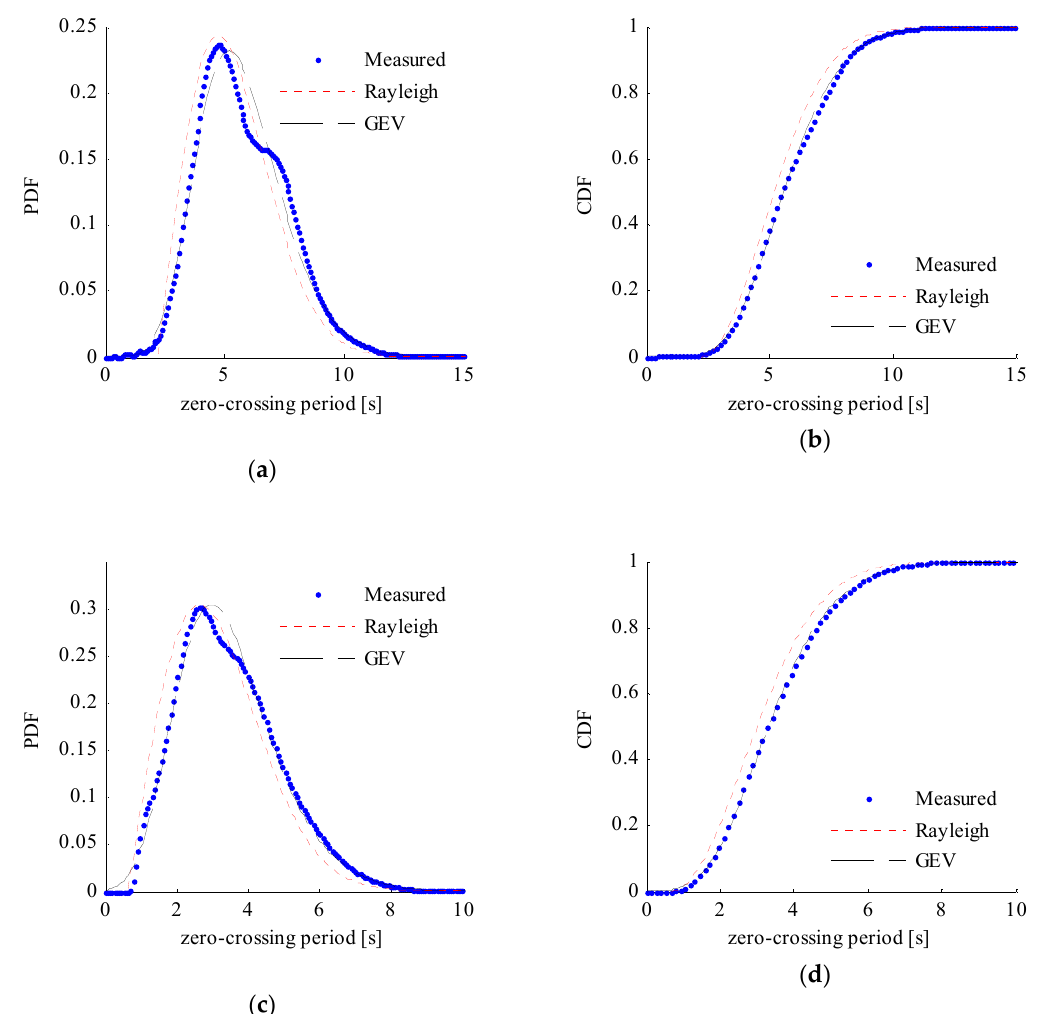
Figure 13. Computed PDF and CDF for the zero-crossing period of the measured data, and the Rayleigh and GEV distributions: ( a ) zero-crossing period PDF when H s = 1.0583 m; ( b ) zero-crossing period CDF when H s = 1.0583 m; ( c ) zero-crossing period PDF when H s = 0.6069 m; and, ( d ) zero-crossing period CDF when H s = 0.6069 m.